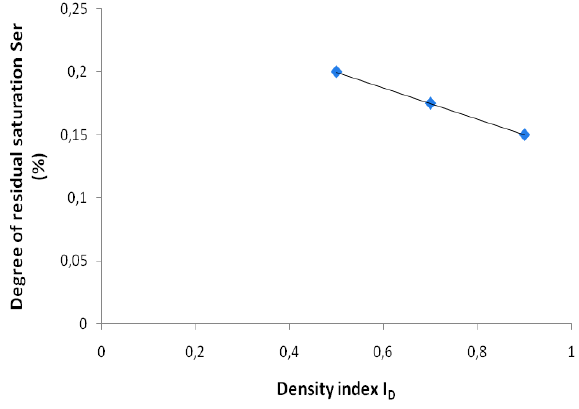
Figure 7: Variation of the degree of residual saturation as a function of the density